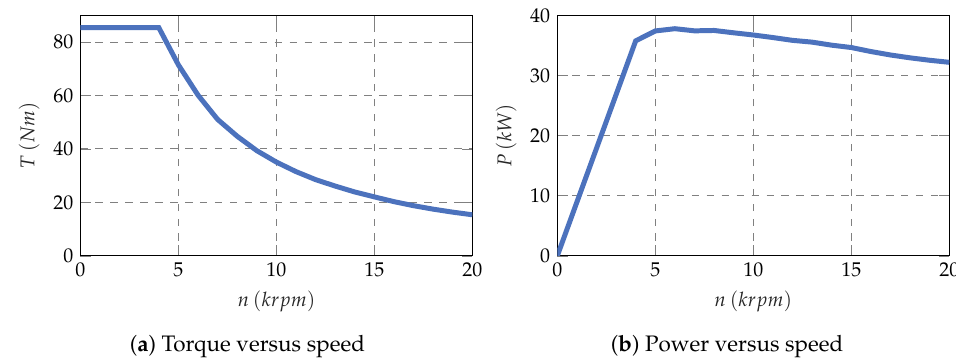
Figure 13. Torque and power versus speed of PRC-2 machine.